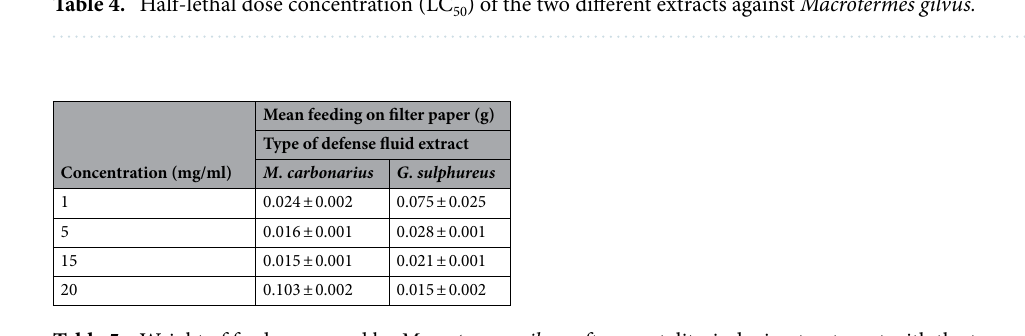
Table 4. Half-lethal dose concentration (LC 50 ) of the two different extracts against Macrotermes gilvus.